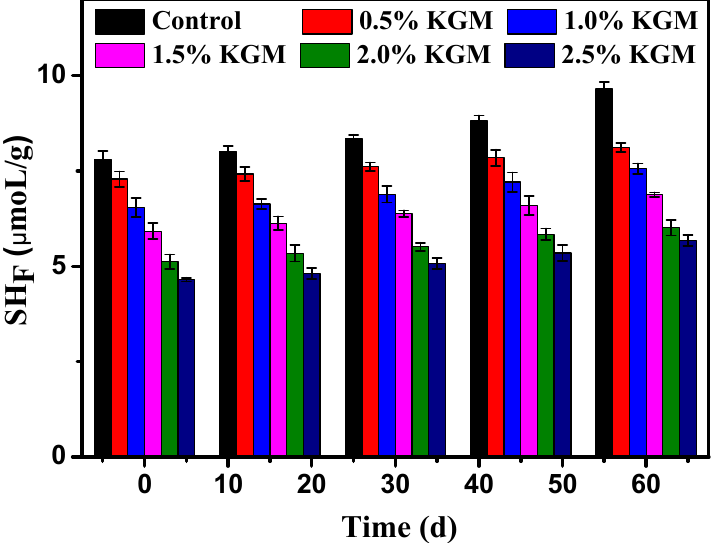
Figure 3. Free sulfhydryl content (E) of gluten proteins with different proportions of KGM added during frozen storage.